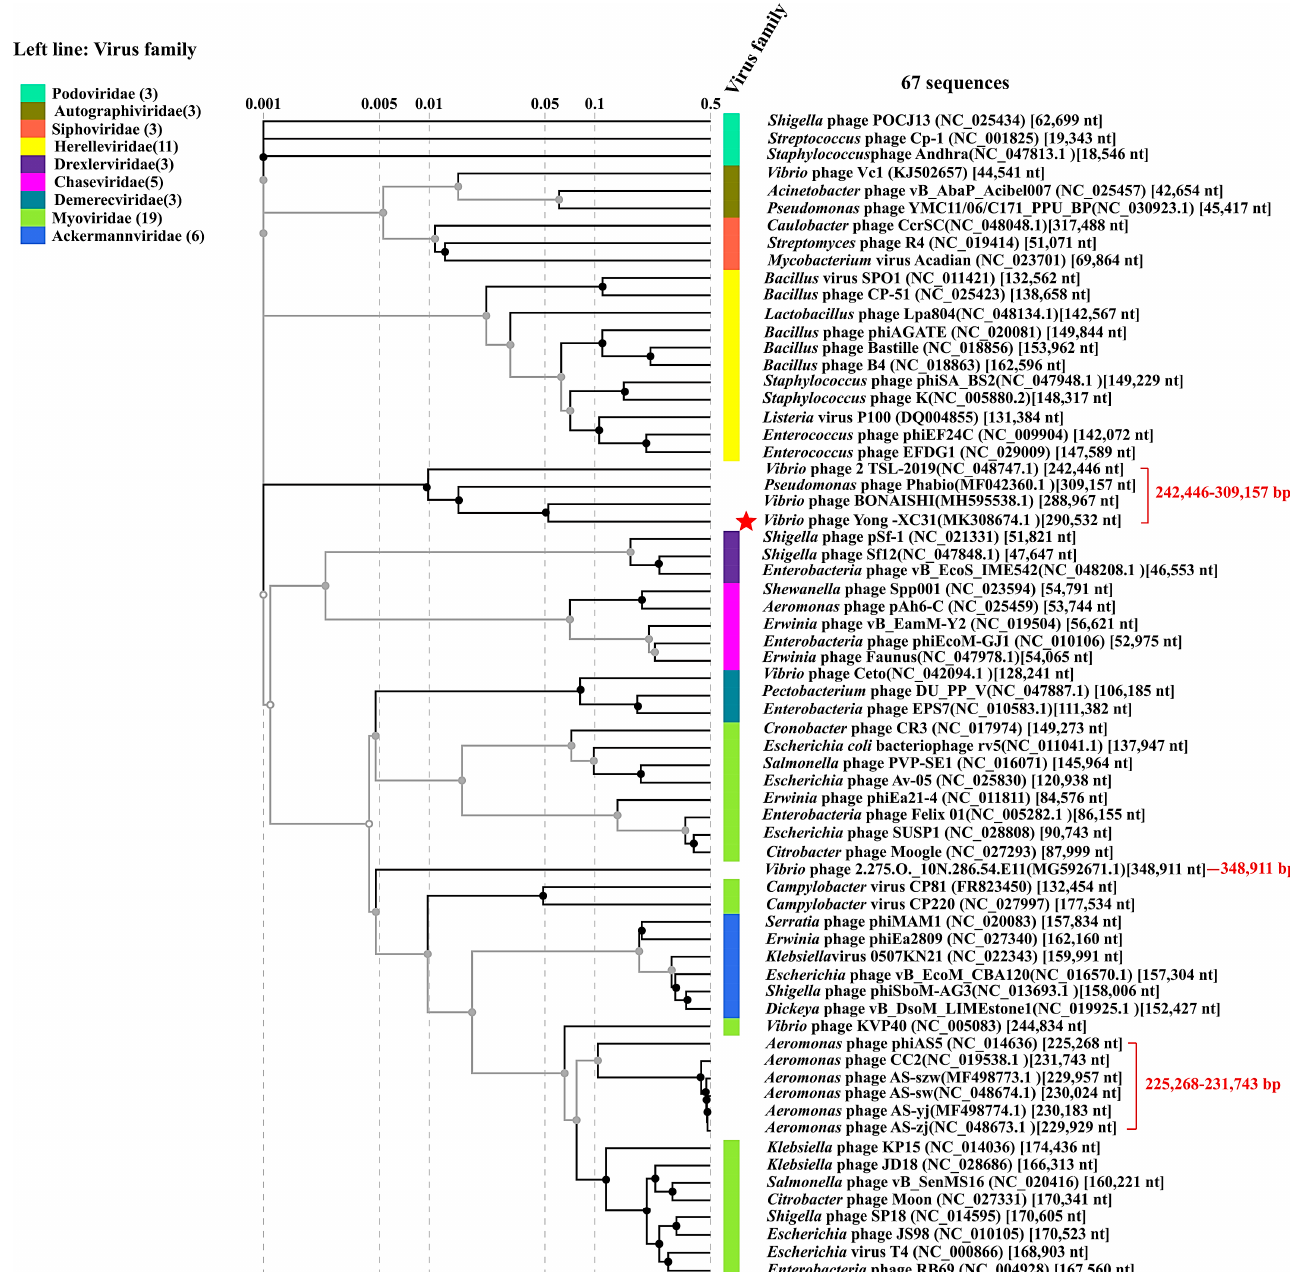
Figure 8. The proteomic tree is generated using ViPTree online based on genome-wide similarities determined by tBLASTx. 56 type species of nine families belonging to the order Caudovirales, Vibrio phage Yong-XC31, and 10 giant phages in Table 2 were included in the analysis. Bacteriophage family assignments according to the official ICTV classification are provided with different color bars. No color bar is marked to unclassified giant phages. Red star refers to Yong-XC31. The sizes or size ranges of the giant phage genomes are shown in red font on the